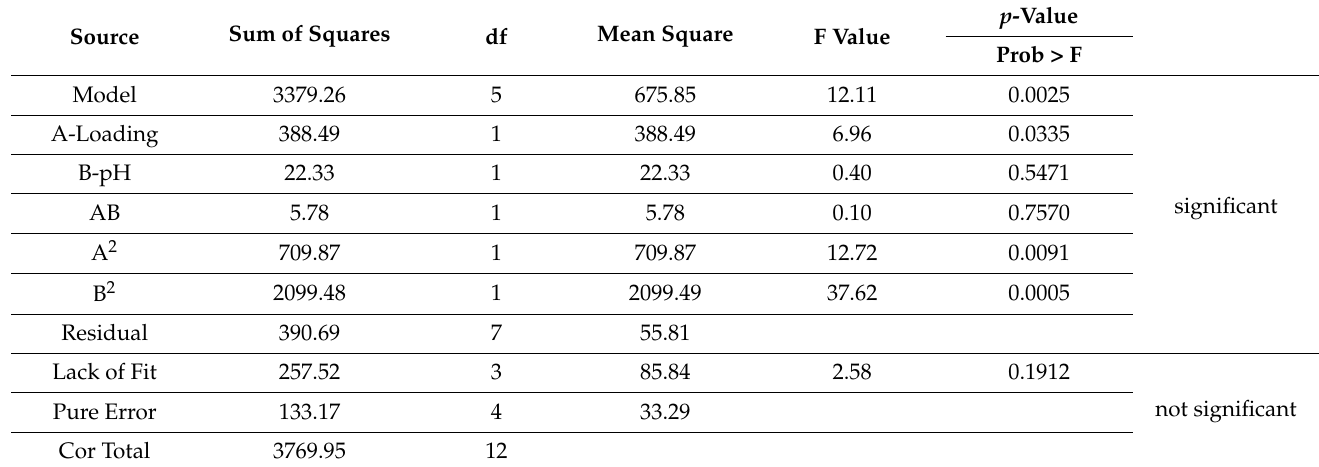
Table 6. Analysis of variance (ANOVA) for water contact angle